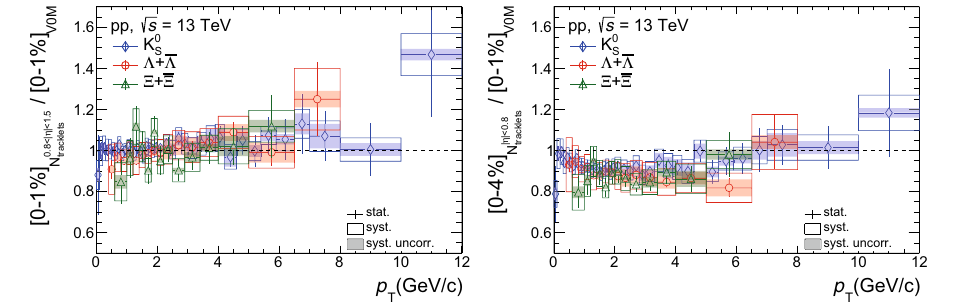
Fig. 7 Ratio of p T spectra of K 0 , (cid:3) and (cid:4) obtained with two different tor. Statistical and systematic uncertainties are shown by error bars S estimators for multiplicity classes with comparable average d N ch / d η and empty boxes, respectively. Shadowed boxes represent uncertainties . 8 < | η | < 1 . 5 uncorrelated across multiplicity value ( (cid:3) d N ch / d η (cid:4) (cid:7) 26); the numerator does refer to the N 0 tracklets | η | < 0 . 8 ( N ) estimator while the denominator refers to the V0M estima- tracklets